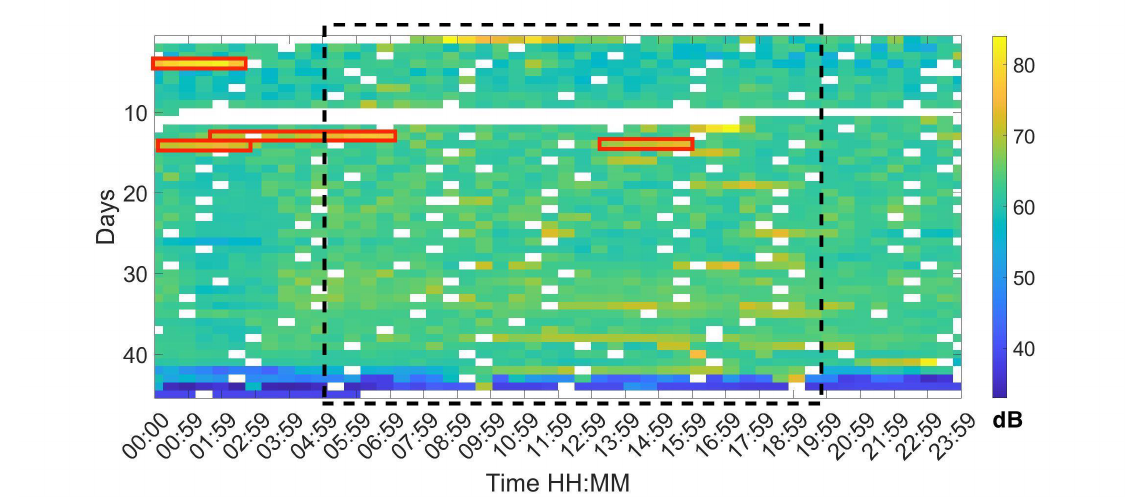
Figure 6. Map of the L eq at 30 min intervals during the 44 days of a complete production cycle. The red rectangles correspond to the areas where there is a high L eq measurement due to machinery.